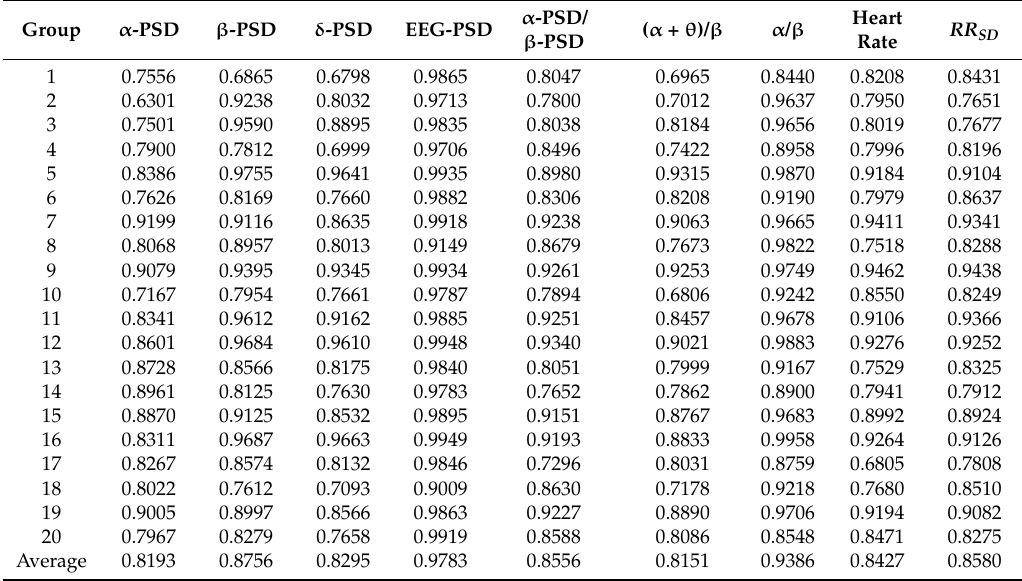
Table 2. The degree of correlation between the physiological parameters and the reaction time. Group α